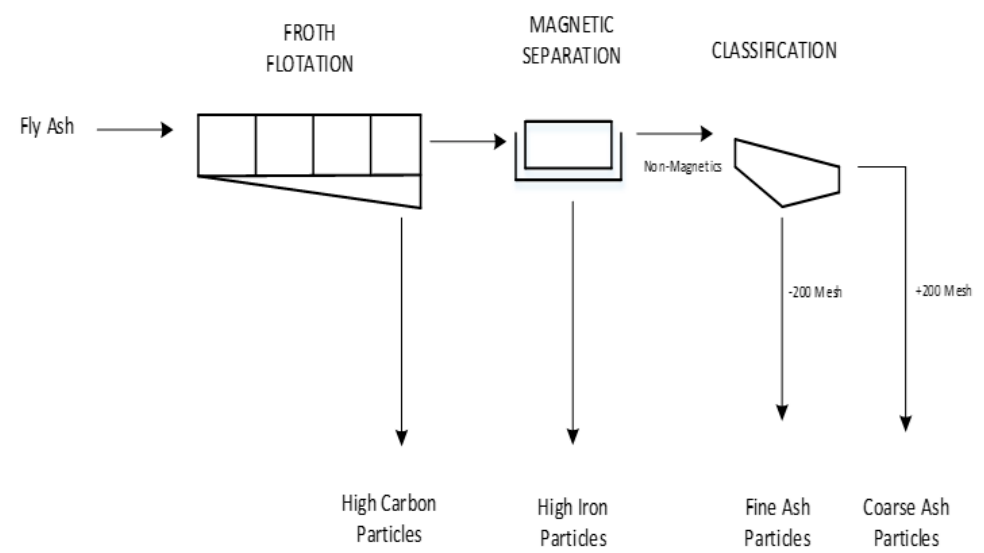
Figure 2. Basic beneficiation scheme for the fly ash. As described in the text, the froth flotation step is preceded by screening to eliminate oversized (16 mesh; 1 mm) particles.